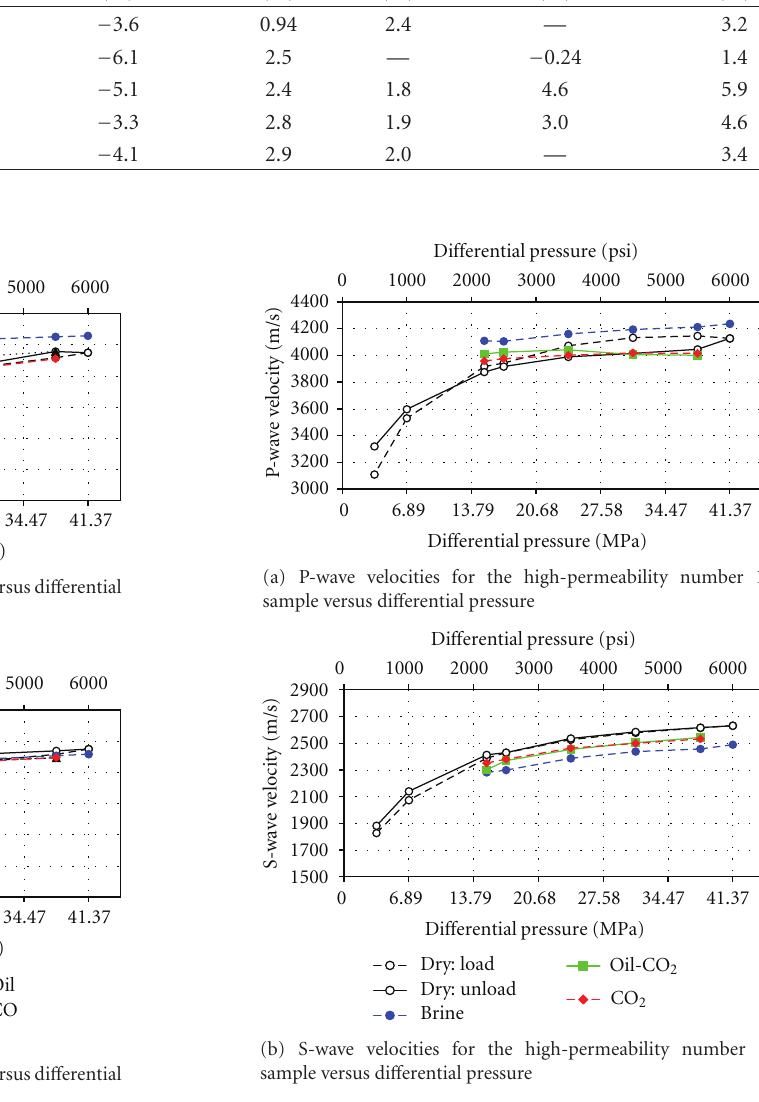
Table 3: Percentage change of P-wave velocity with increasing di ff erential pressure from 15.17 MPa to 37.92 MPa. Sample